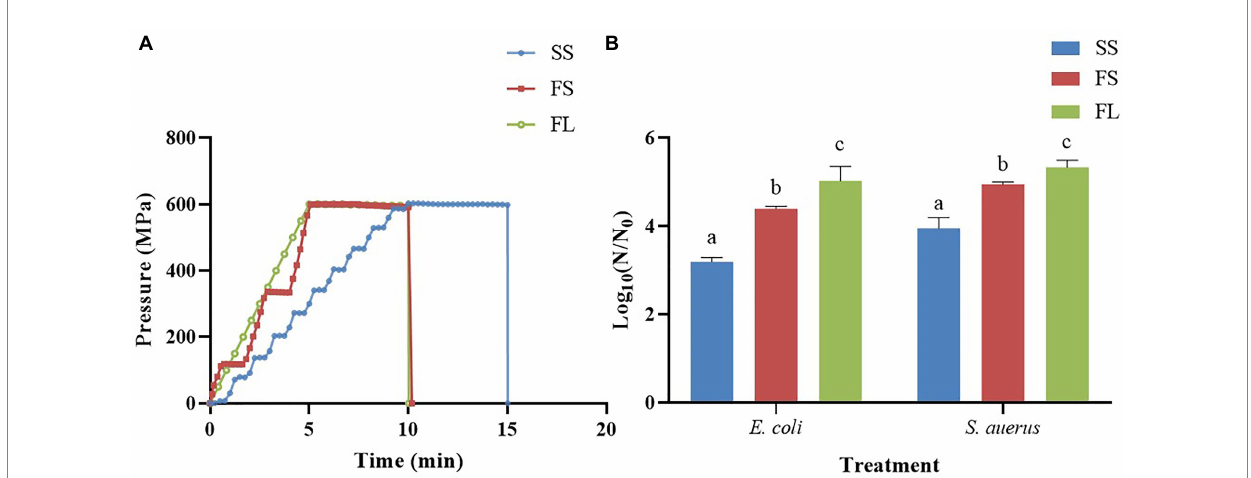
FIGURE 1 Effects of pressurization rates and modes on inactivation of E. coli (250 MPa/5 min) and S. aureus (450 MPa/5 min). (A) Pressure profiles of SS, FS and FL as a function of time. SS was pressurized at a rate of 60 MPa/min by a one-way intensifier with a come-up-time of 10 min. FS was pressurized at 120 MPa/min by a one-way intensifier with a come-up-time of 5 min. FL was pressurized at 120 MPa/min by a two-way intensifier with a come-up-time of 5 min. The depressurization rate was fixed in SS, FS and FL (<3 s). (B) Effects of pressurization rates and modes on inactivation. Different letters in the same strain shows significant difference.